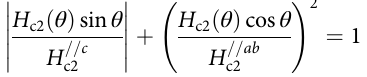
Fig. 4e. The extracted angular dependent upper critical fi elds at 10% of normal resistivity are plotted in Fig. 4e. A clear cusp is observed at θ = 90°, at which the magnetic fi eld parallels to the ab -plane. The overall H c2 ( θ ) data can be fi tted by Tinkham for- mula for 2D SC 30